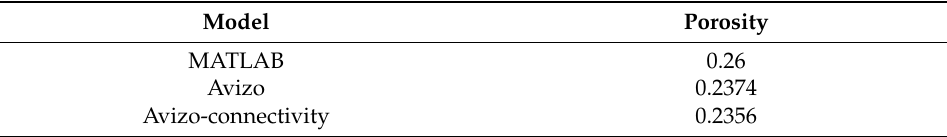
Table 2. Comparison of model porosity.